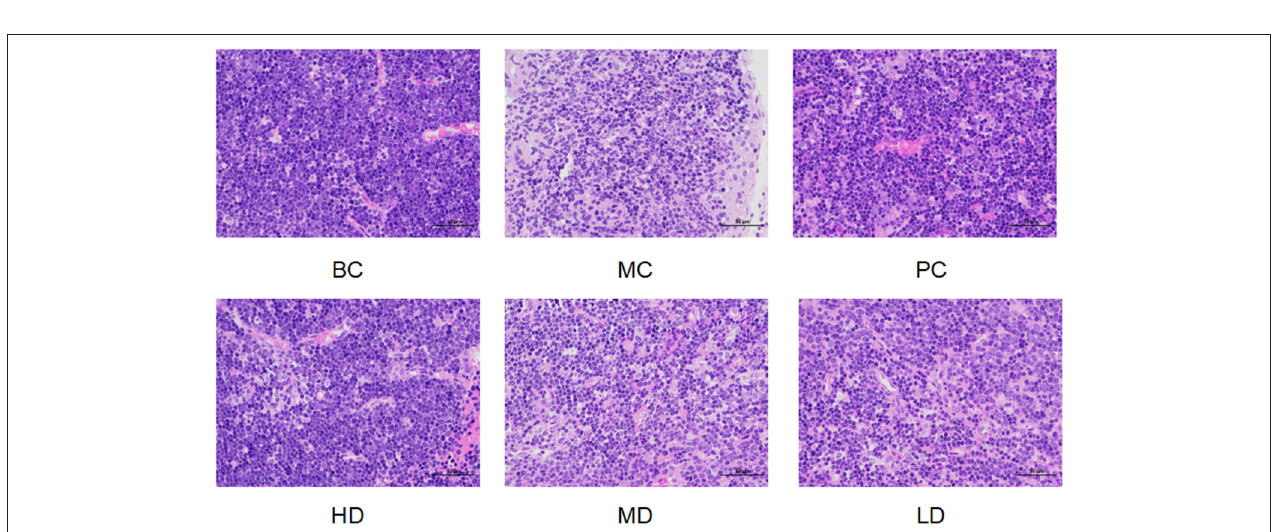
FIGURE 3 | Effect of F. velutipes polysaccharide on thymus organ in mice.